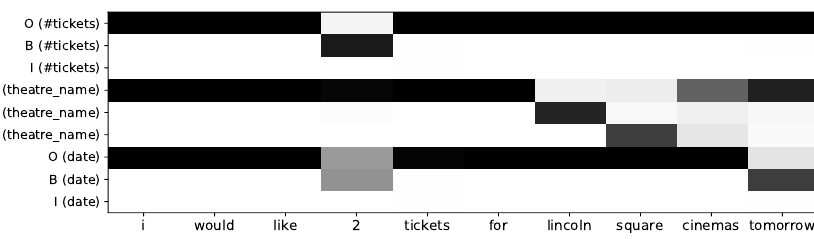
Figure 6. Probabilities of the IOB labels for each slot in the CT